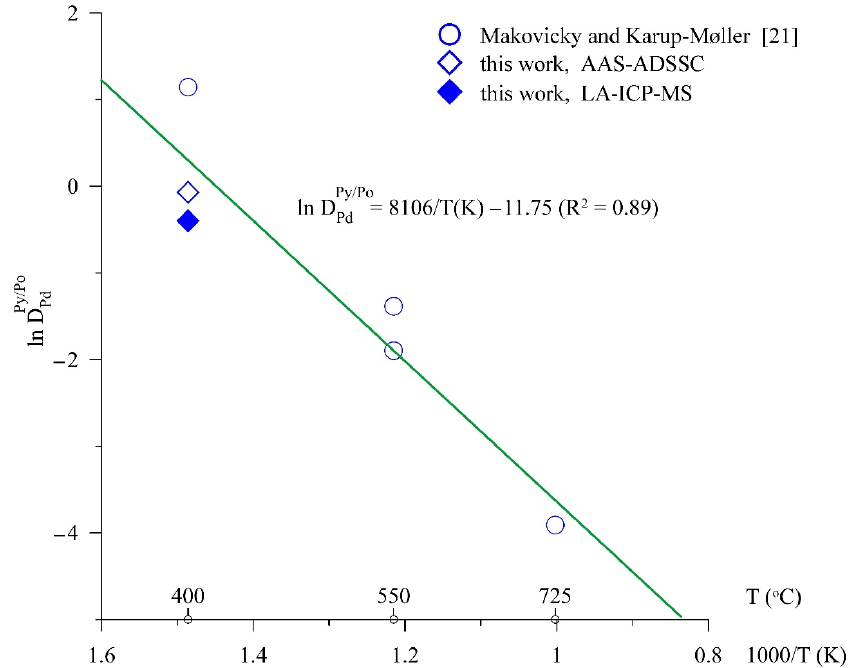
Figure 5. Palladium distribution coefficient between pyrite and pyrrhotite as a function of temper ‐ ature.